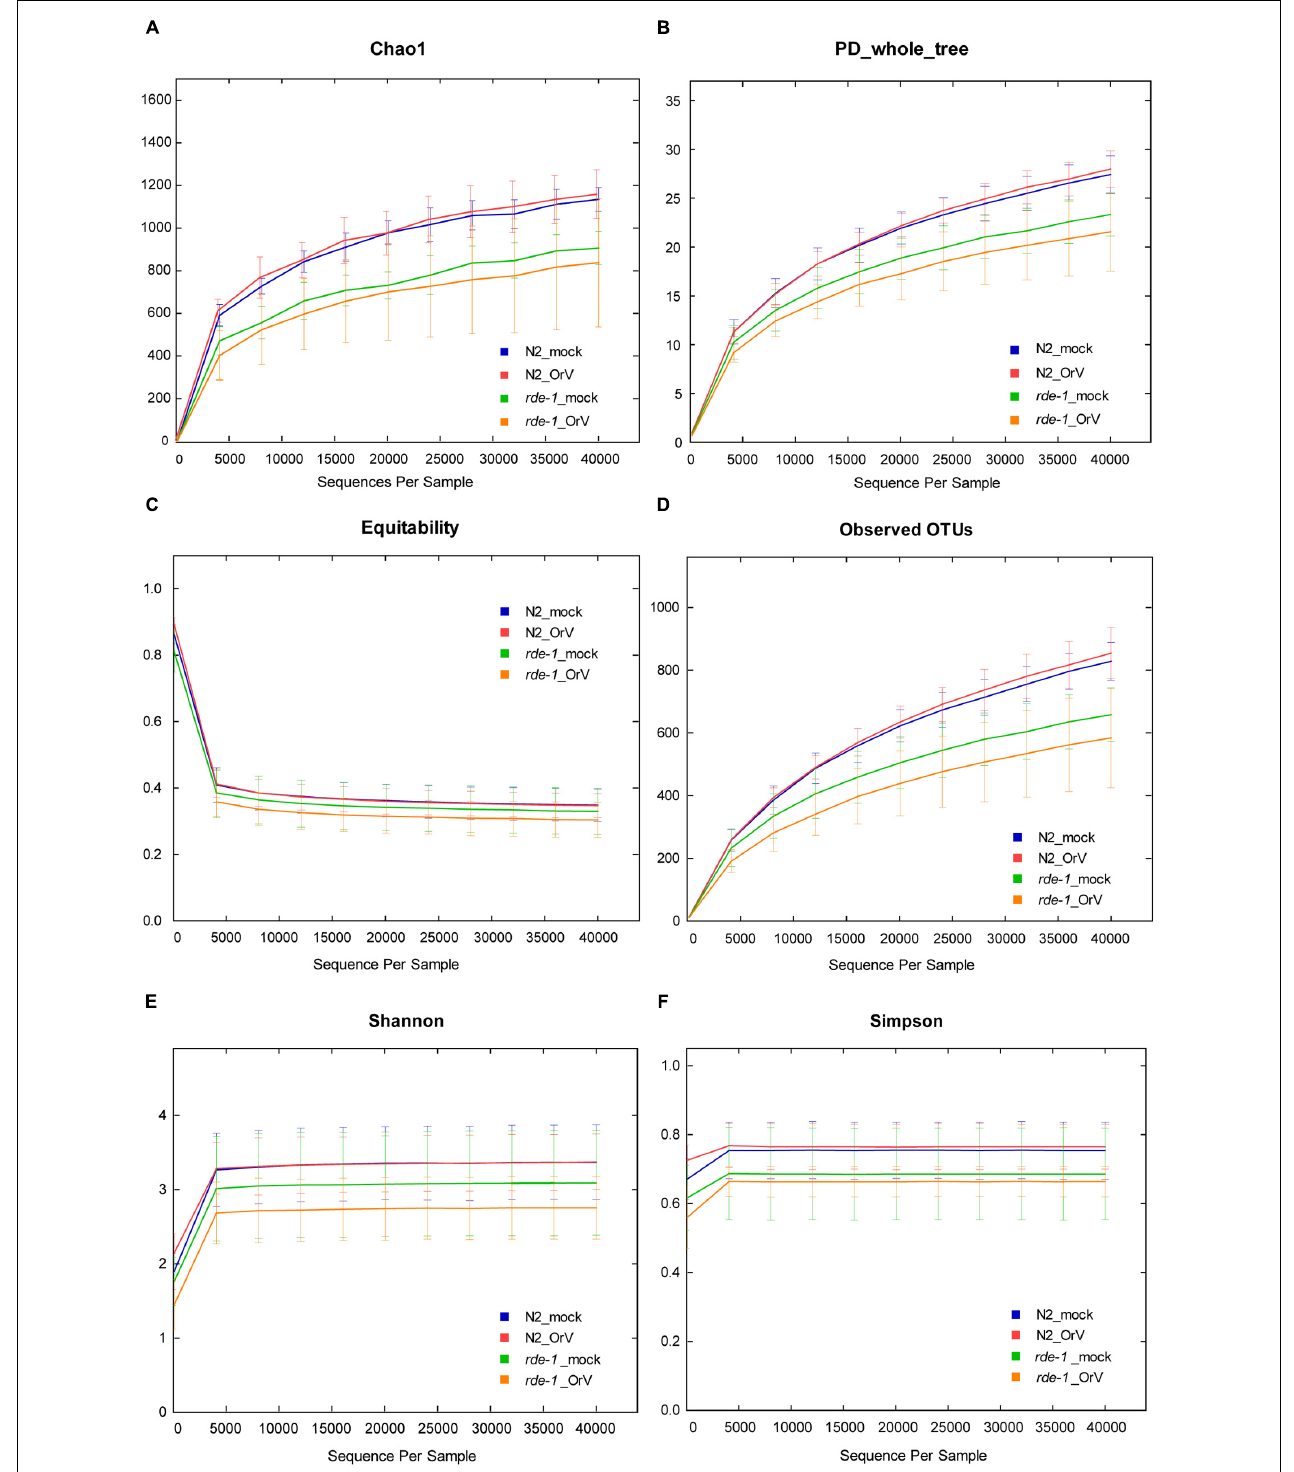
FIGURE 3 | Calculation of alpha diversity values for comparison of the total microbial diversity of uninfected and Orsay virus-infected groups of N2 and rde-1 ( ne219 ) mutant. (A) The estimated OTU numbers (Chao1) of N2 were greater than that of rde-1 ( ne219 ) mutants, which especially decreased in Orsay virus-infected rde-1 ( ne219 ) mutants. (B) Phylogenetic diversity (PD) measures of community diversity. (C) Equitability index of the microbiota data for N2 and rde-1 (ne219) mutants. (D) The numbers of observed OTUs decreased in both uninfected and Orsay virus-infected rde-1 ( ne219 ) mutants. (E) Microbial community diversity analysis (Shannon index) showed that the N2 community exhibited greater diversity. (F) Simpson index measures of community diversity.